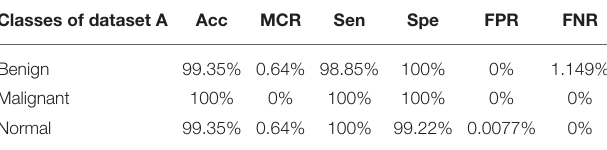
TABLE 14 | Statistical measures of dataset A.